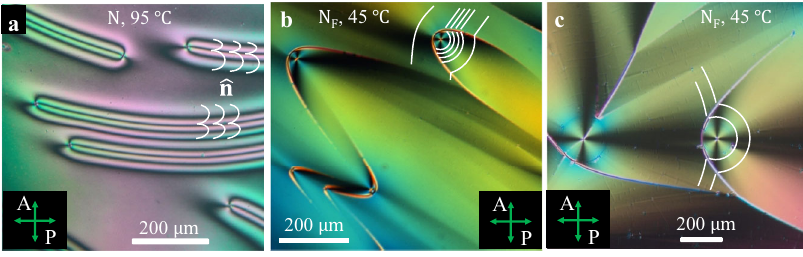
Fig. 5 Polarizing microscopy textures of DIO at the glycerin substrate. a N fi lm shows 2 π domain splay-bend walls. b , c N F texture of conic-sections with prevailing circular bend; in ( b ), elliptical defects separate regions between mostly circular bend and mostly uniform P fi eld, while in ( c ), hyperbolic shapes separate domains with predominantly circular bend. Film thickness 7 µ m in ( a , c ), and 5 µ m in ( b ); ^ n is depicted by white